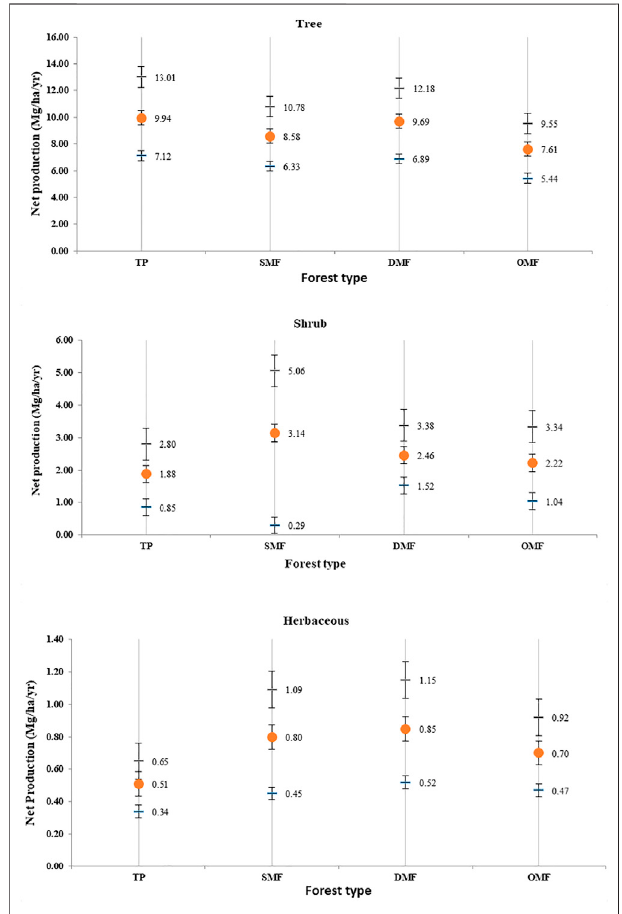
FIGURE 10 | Estimates of total production (Mg/ha/yr) with 95% con fi dence interval of trees, shrubs and herbs for different forest types in tropical forests of